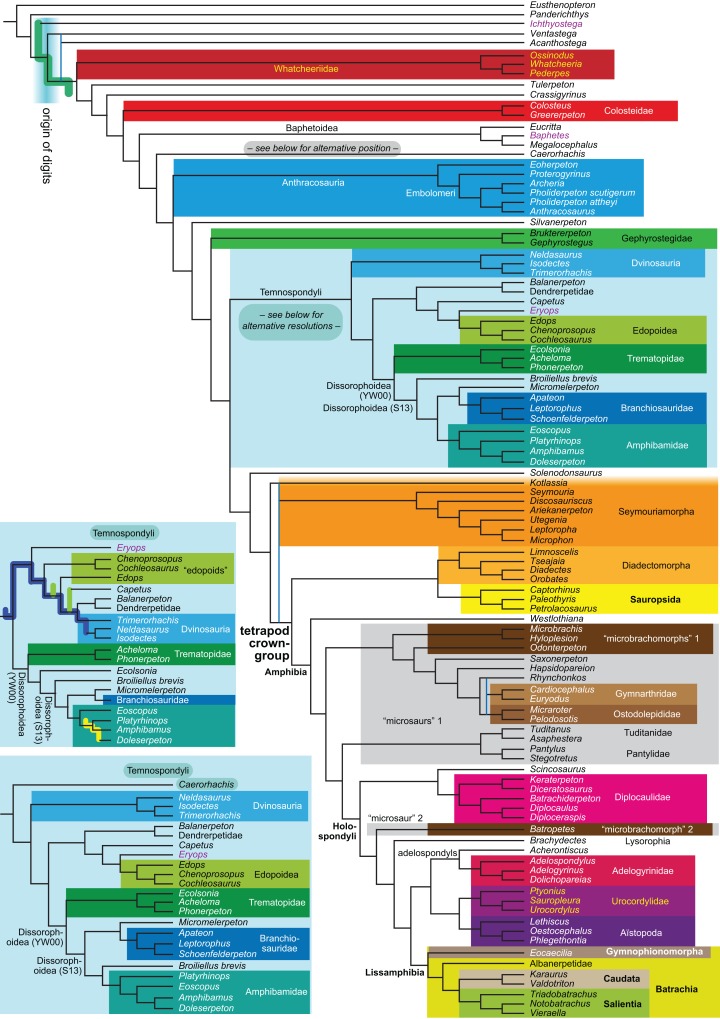
Representation of some of the MPTs (length: 2,182 steps) from Analysis R1, performed on our revised matrix—specifically the ones where Anthracosauria is rootward of Temnospondyli.The remaining MPTs from R1, where Anthracosauria is crownward of Temnospondyli, are shown in the next figure. The taxon sample was unchanged from RC07; no constraint was enforced. This tree, like those in the following figures, aims to represent all of the information contained in the MPTs, more than any consensus tree can. The uninterrupted part of the tree (black lines), polytomies excepted, is present in all MPTs represented in this figure as a backbone on which the branches connected only by colored underlays have varying positions; all nodes underlain in color are absent from the strict consensus. The teal underlay in this figure connects the two positions of Ichthyostega that occur in different MPTs: one node more rootward, or one node more crownward, than Ventastega and Acanthostega; the green underlay connects the two positions of Capetus in the upper inset, the blue one the two of the (Neldasaurus + Isodectes) clade, the yellow one the two of Doleserpeton. In this and the following figures, branches with only two neighboring positions in different MPTs are indicated with blue lines: for example, the clade of all seymouriamorphs except Kotlassia is the sister-group of Kotlassia or of the tetrapod crown-group. Trichotomies that are resolved in all three possible ways in different MPTs (none in this figure) are shown in the usual way (without a blue line). Equally parsimonious alternatives that would be confusing if shown on the same tree are shown in the insets to the left, concerning in this case Temnospondyli and Caerorhachis, which may or may not (with equal parsimony) be a temnospondyl.